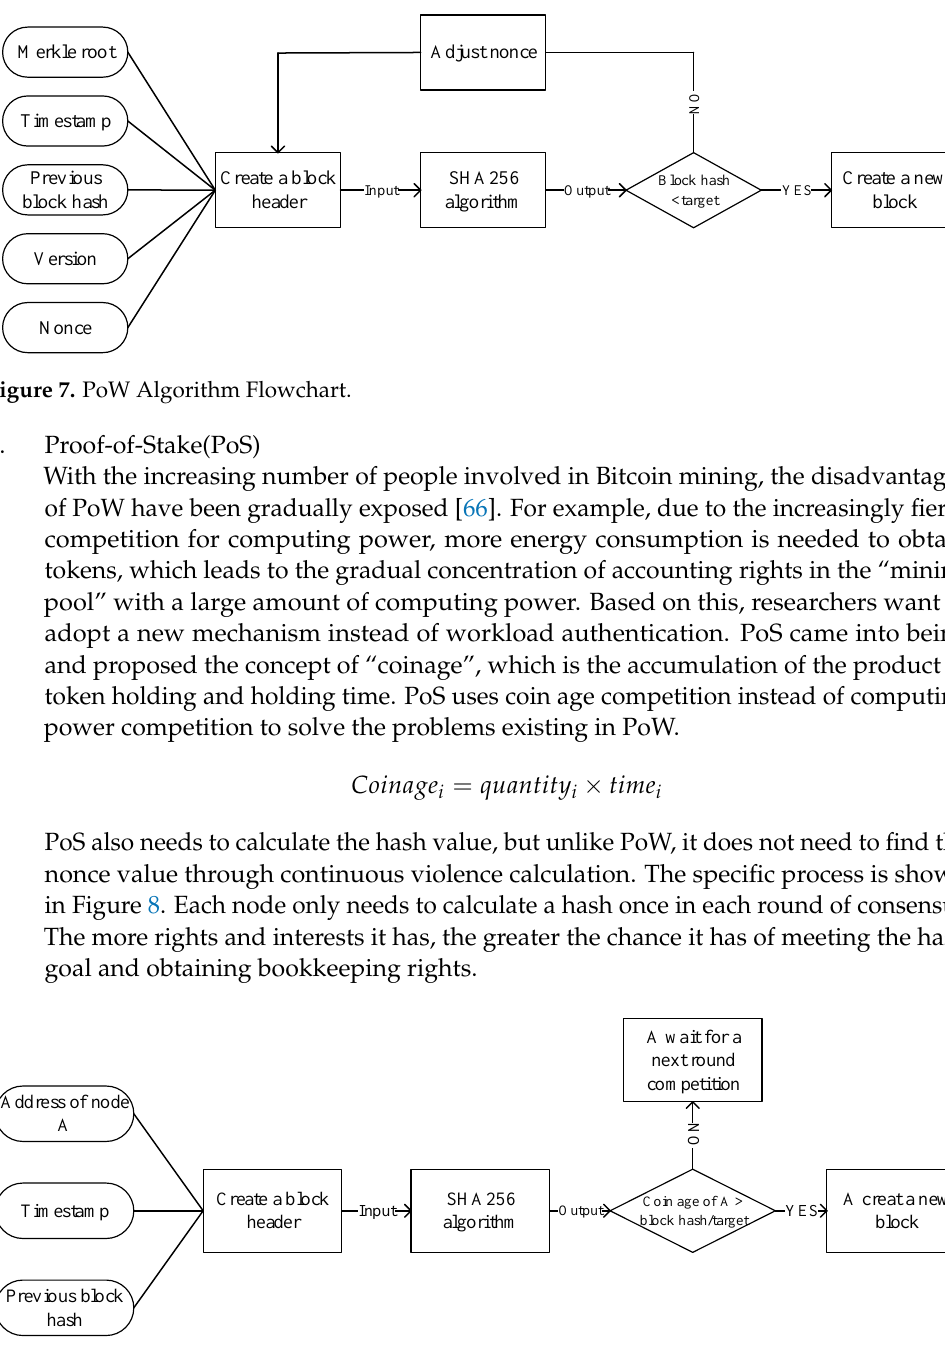
Figure 8. PoS Algorithm